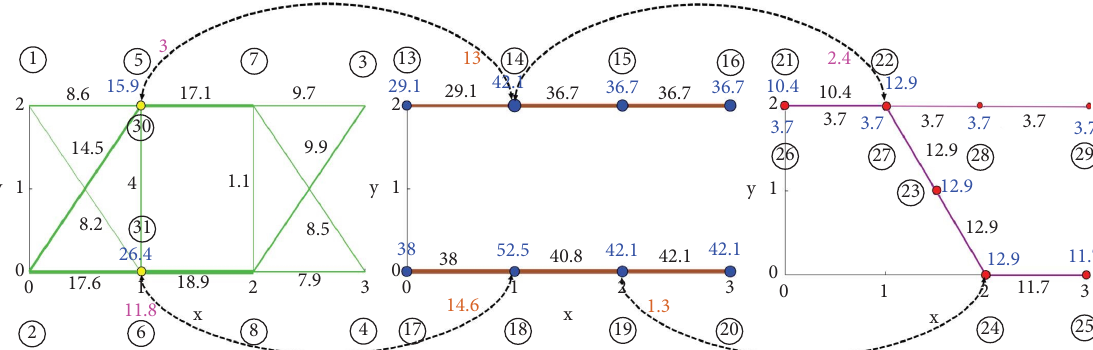
Figure 9: Flow distribution of GA1 scheme.